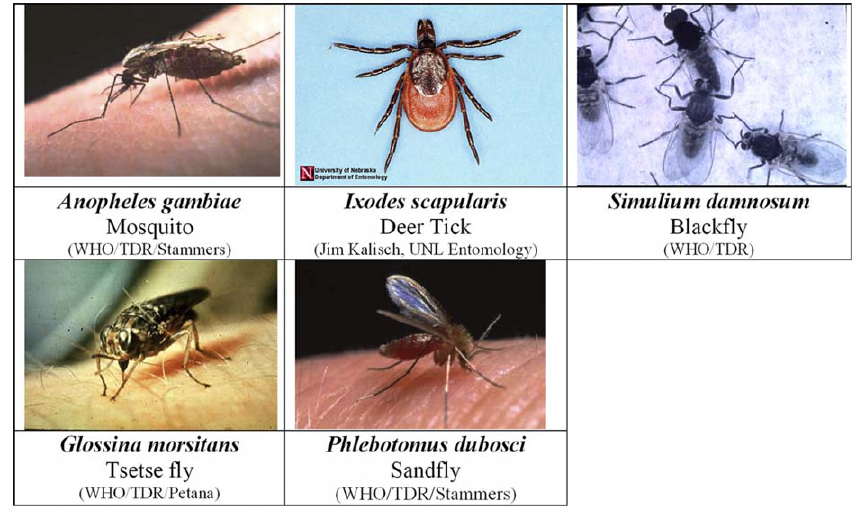
Figure 1. Arthropod Vectors That Are Discussed in This Paper